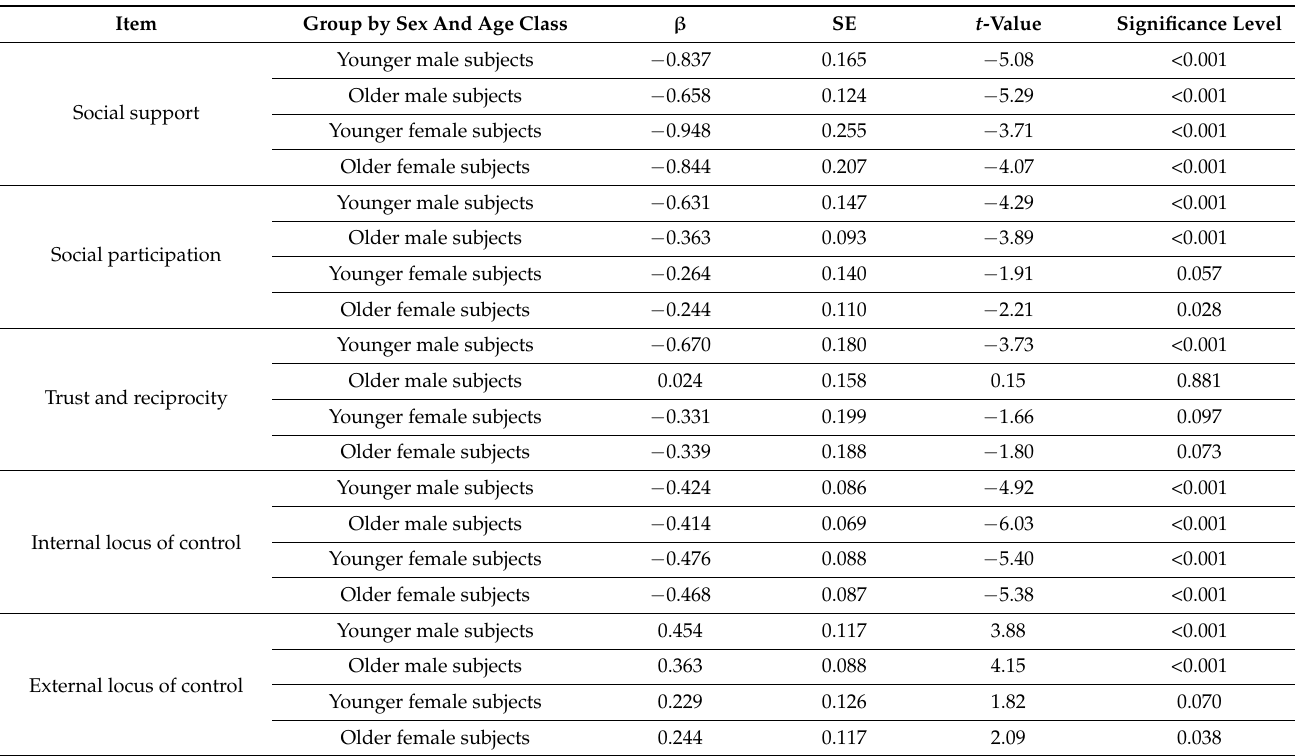
Table 3. Adjusted # regression coefficient ( β ) with its standard error (SE) on impaired mental health regarding social capital and locus of control for the four group of objective and explanatory variables according to the four groups by sex and age classes $